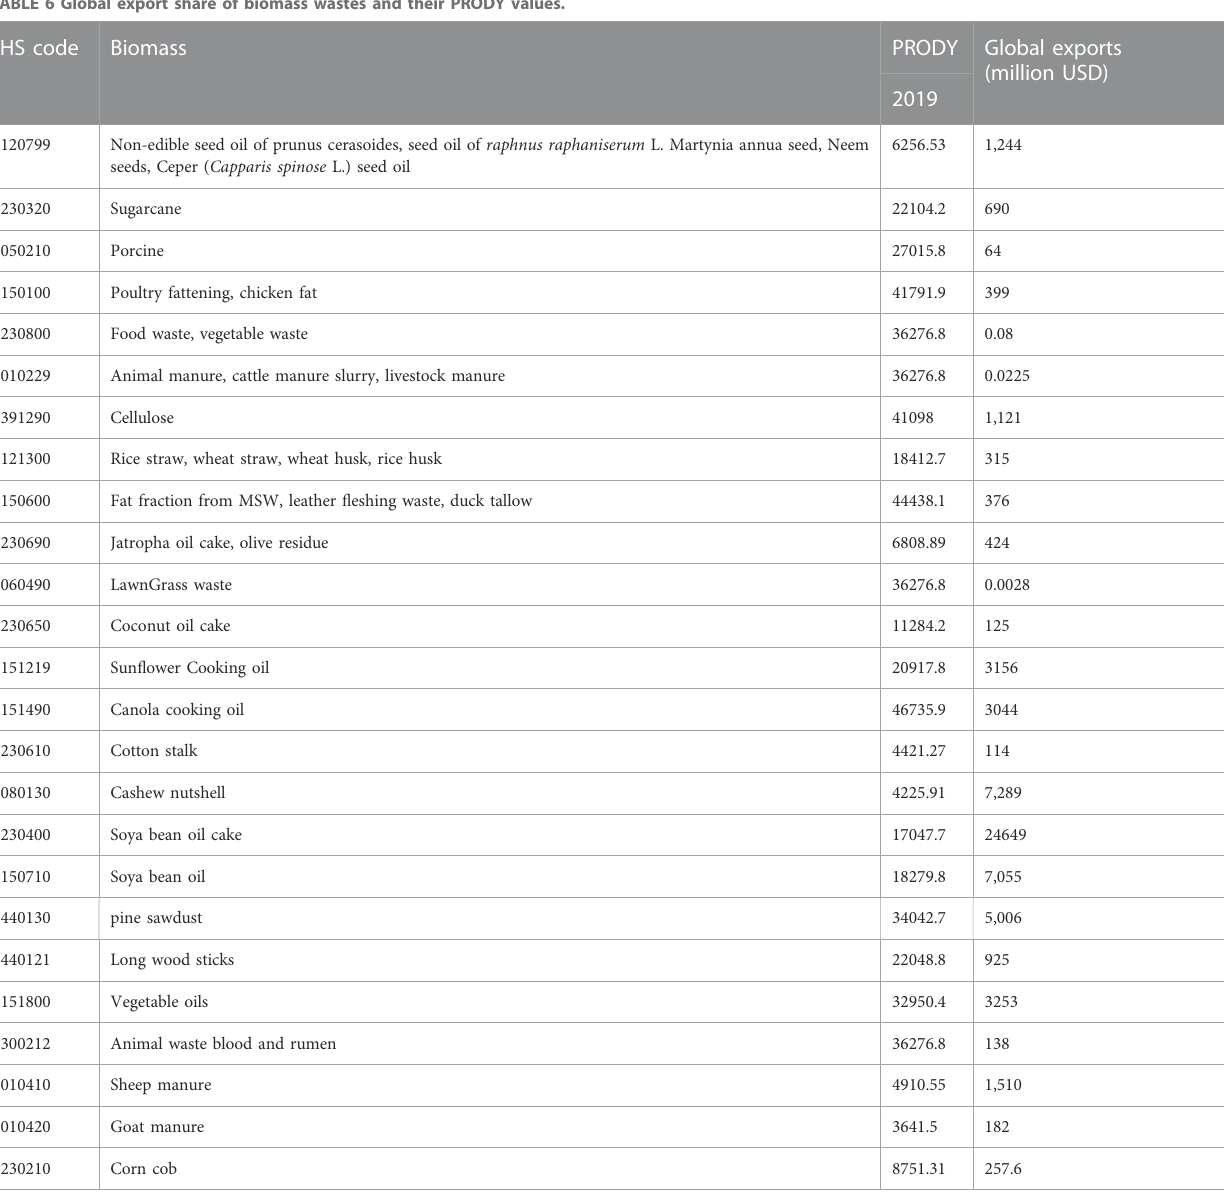
TABLE 6 Global export share of biomass wastes and their PRODY